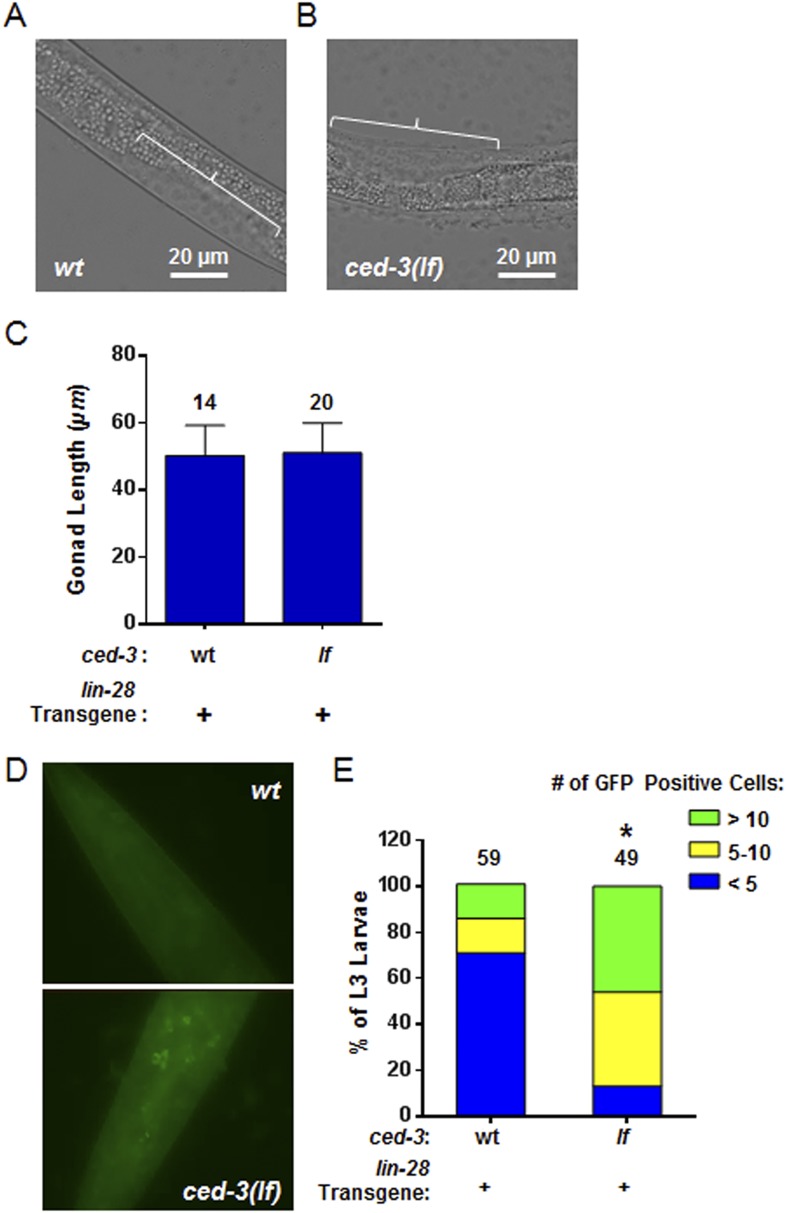
Larval staging and persistent LIN-28::GFP expression.(A–C) Analysis of gonad length in LIN-28(+) transgenic lines with ced-3(wt) or ced-3(lf). We first picked L3 stage animals in the blind on a non-fluorescent microscope. Prior to GFP illumination, we assessed the sub-stages of animals by measuring the gonad length of the animals. This was done since the animals had roller phenotype making P cell division difficult to observe and strong defects in LIN-28, directly, are known to have only minor effects on gonad development (Ambros, 1997). Thus, these strains should not be expected to have significant defects in gonad extension and gonad length should serve as a quantifiable metric of larval stage similar to previous reports (Ambros and Horvitz, 1984; Moss et al., 1997; Abbott et al., 2005). The images shown here (A–B) are from the same animals shown in the main Figure 8B–C. The white bars indicate 20 μM. The white brackets indicate the gonads of equal length. (C) No significant difference in gonad length for the L3 samples was observed between the two strains suggesting similar sub-stage. Mean ± SD is shown (p > 0.05, Mann–Whitney test). (D–E) Pseudocolored GFP from DIC head images of L3 larvae and quantitation of the number of cells expressing LIN-28::GFP (p < 0.0001, *compared to wt;(+), Chi-square test comparing the distributions of L3 larvae based on the number of LIN-28::GFP positive cells). ‘+’ indicates the lin-28(+)::gfp integrated transgene previously shown to be functional (Moss et al., 1997). This set of experiments was done completely independently of the ones shown in main Figure 8B–D. A similar method for selection of L3 animals in the blind on a non-fluorescent microscope was used. All animals were visualized for GFP positive cells through multiple focal planes of the head. All images were taken with identical exposure times, and all cells were counted by an individual who did not take the images.